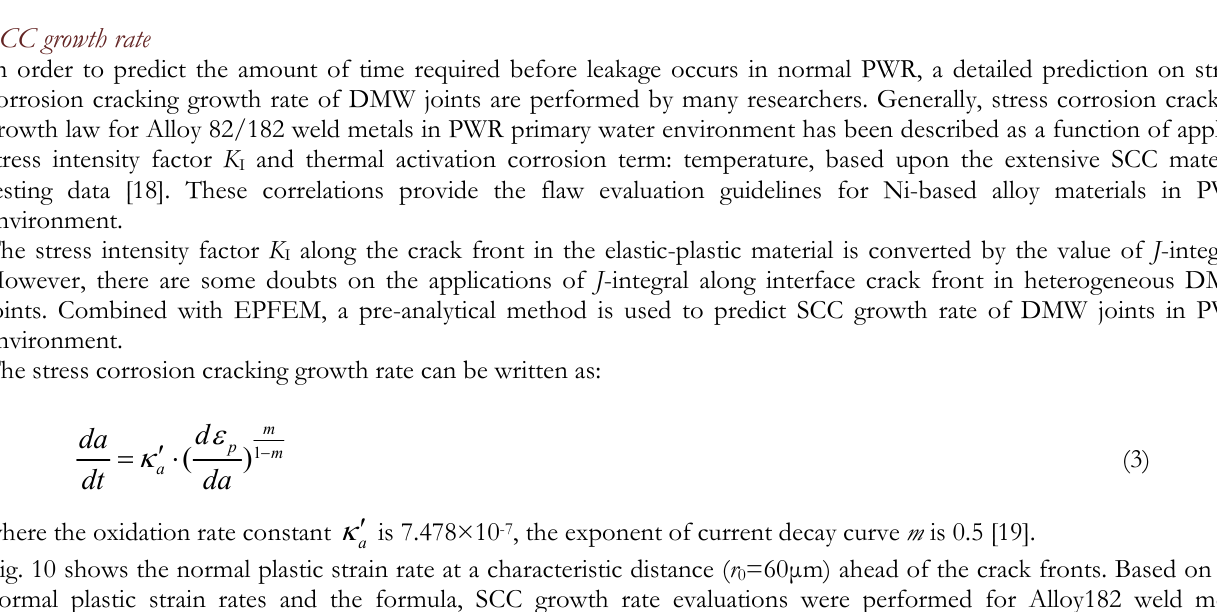
Figure 10: Normal plastic strain rate ahead of crack fronts ( r 0 =60 μ m).